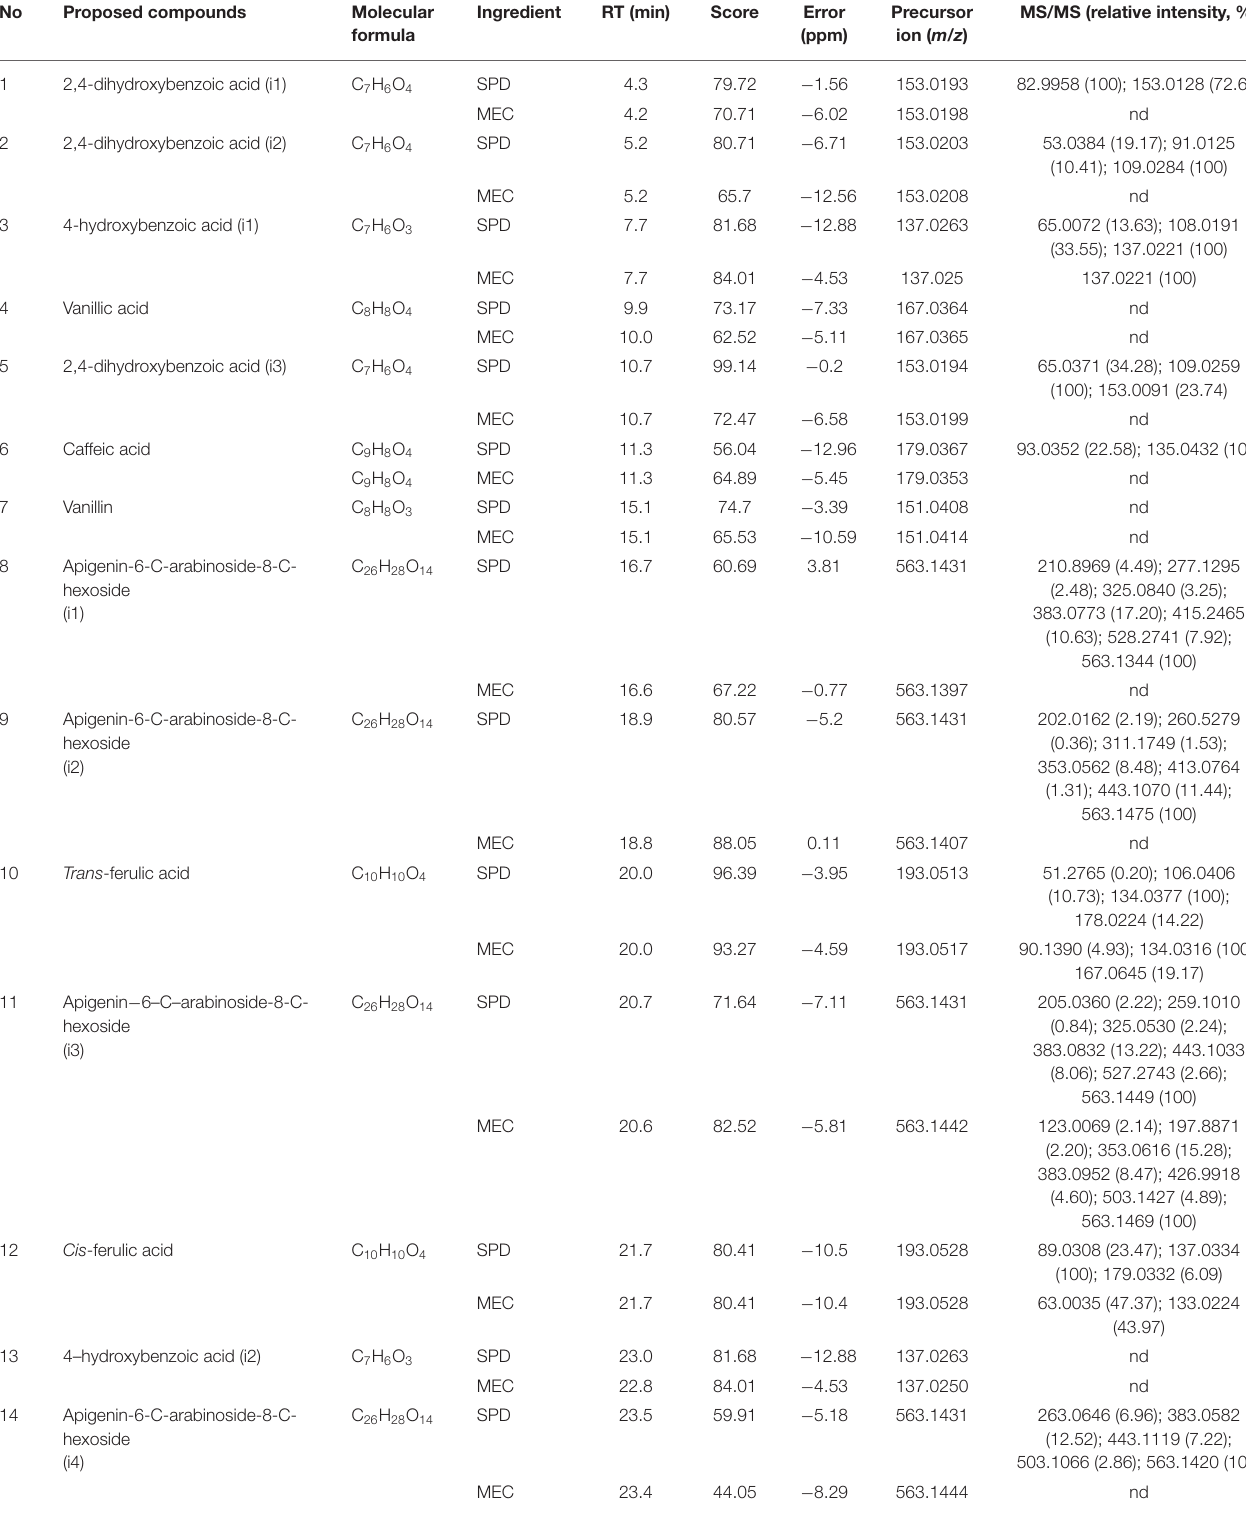
TABLE 3 | Tentative identification of SPD and MEC phenolic compounds by HPLC-ESI-QTOF-MS/MS in negative ion mode.